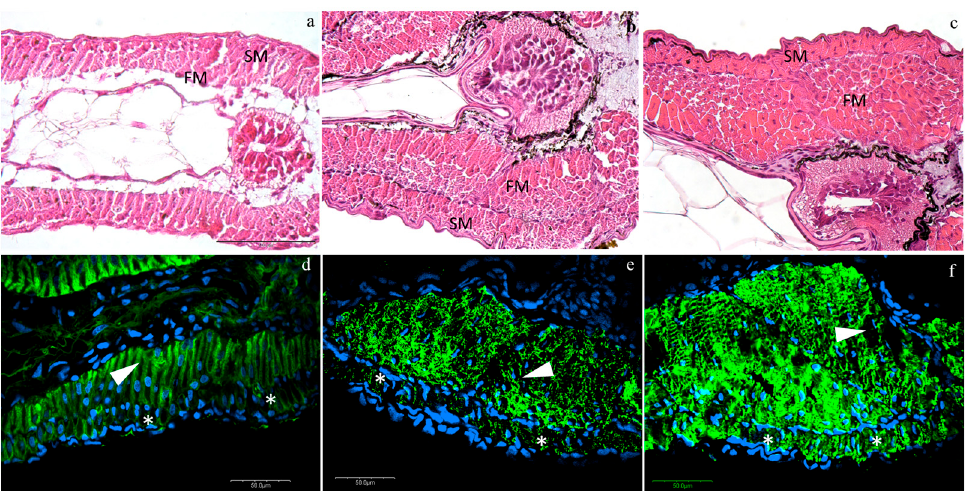
Figure 1 . Representative images of hematoxylin/eosin (HE) ( a–c ) and actin immunofluorescence ( d– f ) at different rearing densities at different time-points: a and d) at T0; b and e) at low density (LD) at T1; c and f) at medium density (MD) at T2. SM, slow muscle cells; FM, fast muscle cells. Green staining, anti-rabbit skeletal muscle actin antibody (ACTA1) immunofluorescence; blue staining, nuclei; asterisks (*), slow muscle; arrow-heads, fast muscle. HE scale bar is located in figure a and refers to 100 µm; actin immunofluorescence scale bars are located in each figure.